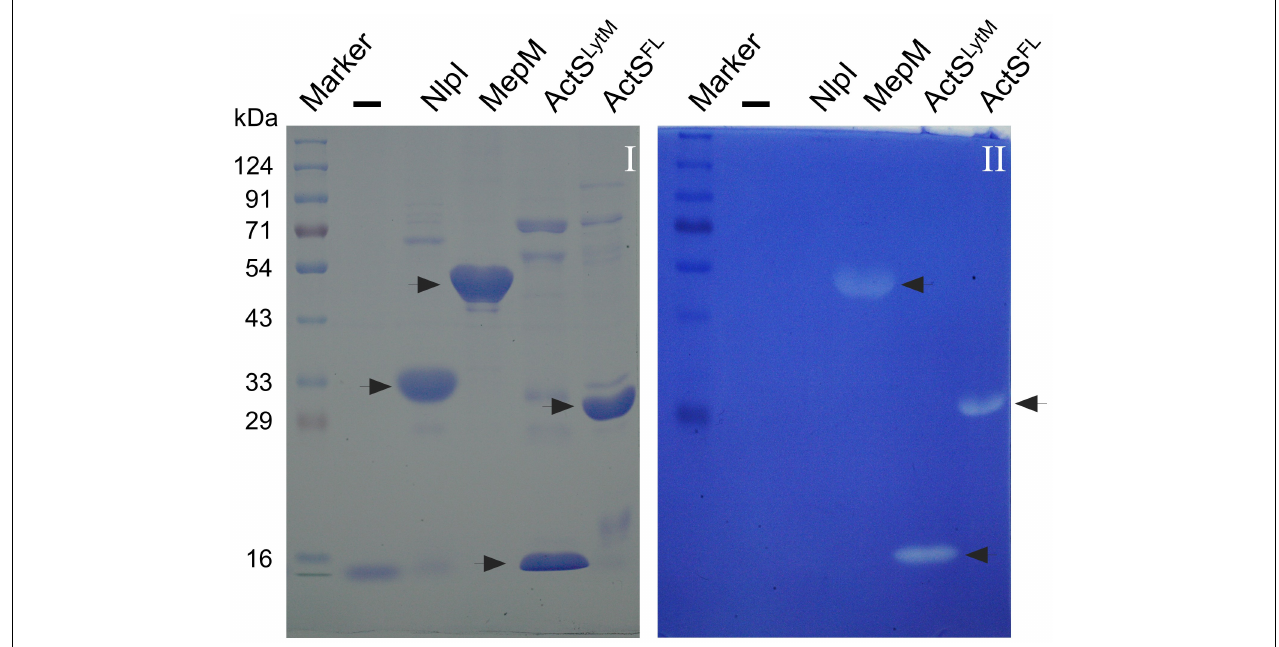
FIGURE 4 | Zymogram assay showing the activity of ActS. Indicated proteins were electrophoresed and the zymogram assay was done as described in the “Materials and Methods” section. Gel-I is stained with Coomassie blue and gel-II containing the M. lysodeikticus cells is stained with methylene blue. Purified ActS FL (lane 6) and ActS LytM (lane 5) exhibit zone of clearance. NlpI (lane 3), a lipoprotein serves as a negative control whereas MepM (lane 4) is a positive